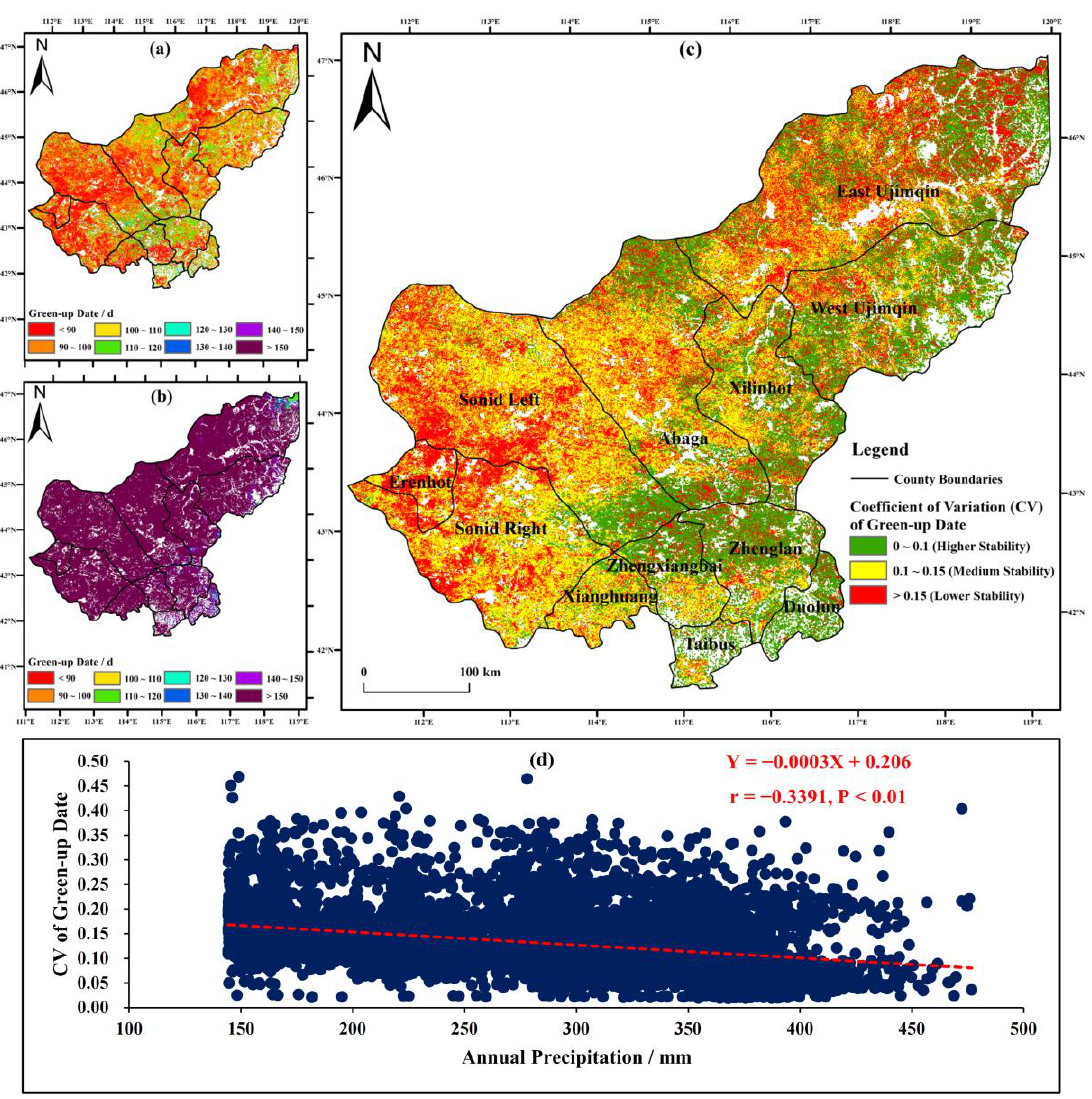
Figure 4. The ( a ) earliest, ( b ) latest and ( c ) CV of green-up date in Xilin Gol grassland; ( d ) correlation between annual precipitation and the CV of green-up